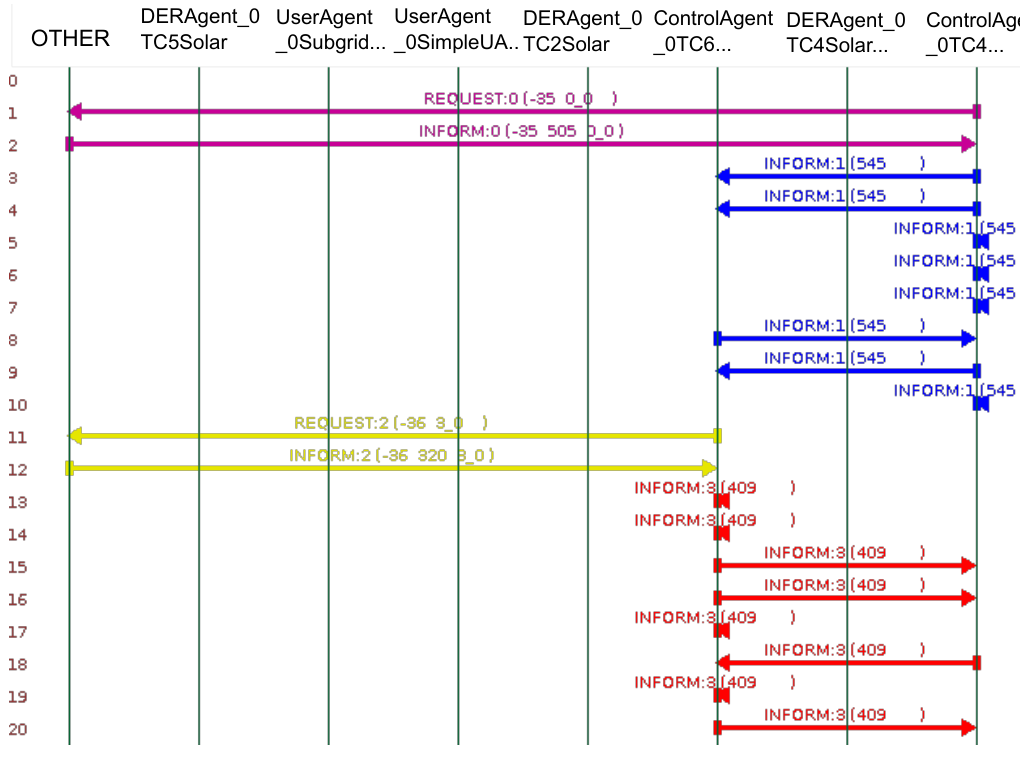
Figure 13. Workflow among Control Agents to deal with an extra demand.